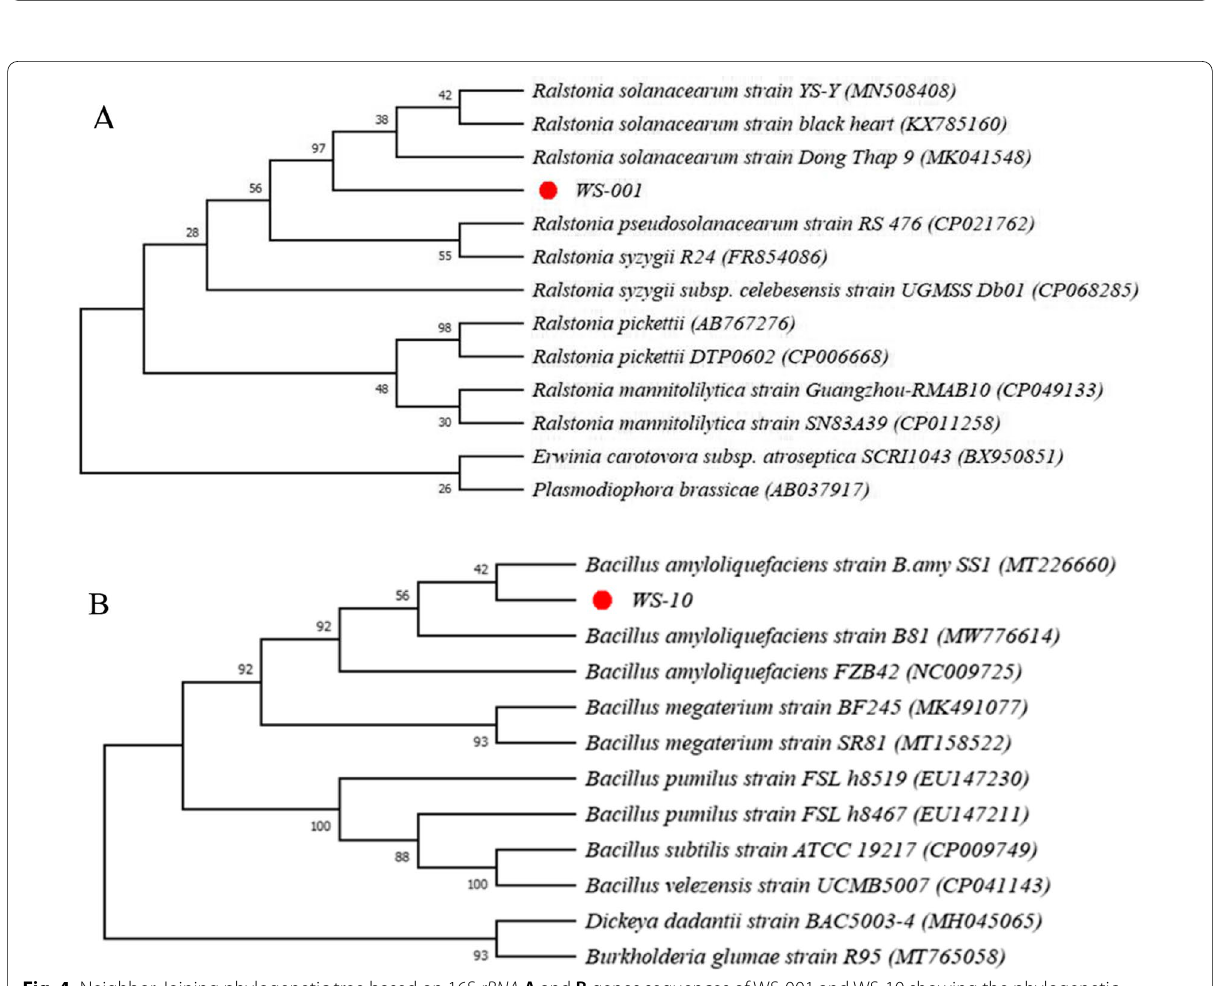
Fig. 4 Neighbor-Joining phylogenetic tree based on 16S rRNA A and B genes sequences of WS-001 and WS-10 showing the phylogenetic relationships between Ralstonia solanacearum and Bacillus amyloliquefaciens , respectively. Bootstrap values of 1000 replications are shown next to the branches. The accession numbers of the NCBI sequences are indicated in